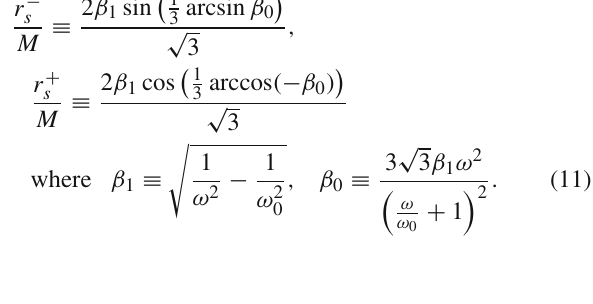
Metric bundles parameterized for the tangent point a g : Eq. (23) Tangent curve to the horizon in terms of r g : Eq. (24) Solution of the tangency condition a g = a ± : Eq. (25), Fig. 17 Metric bundles in terms of the charge Q : Eq.